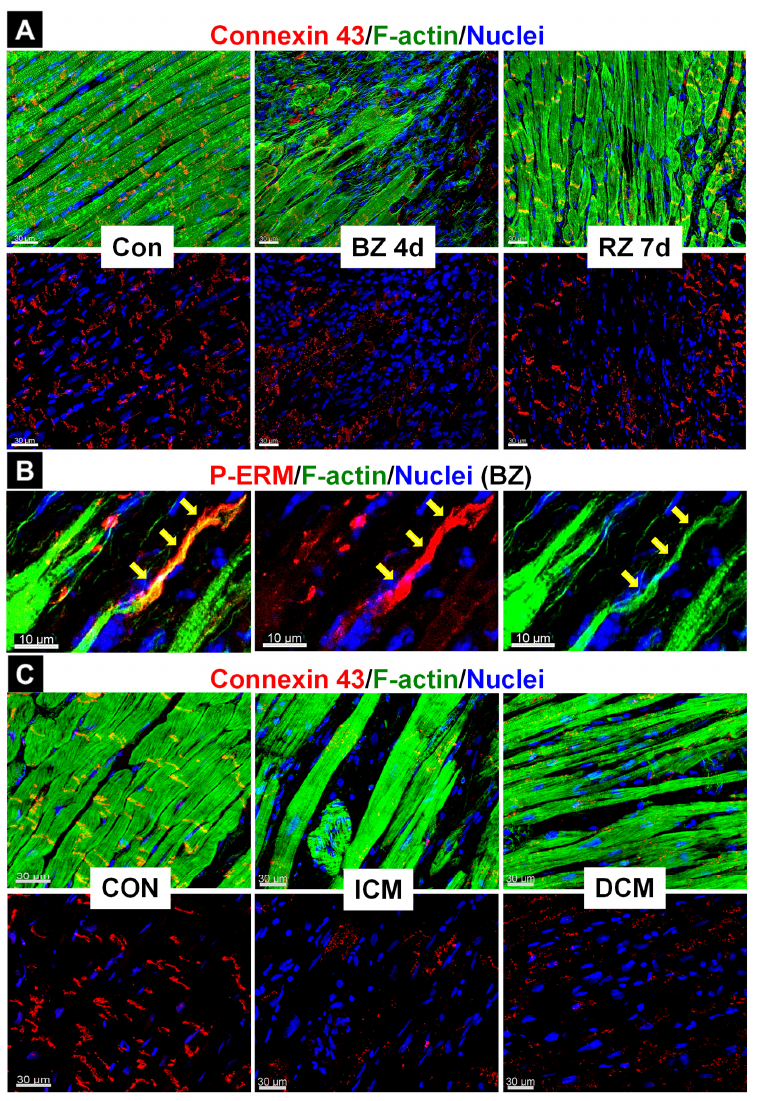
Figure 3. The architecture of intercalated discs is changed in the diseased myocardium. ( A ) Connexin 43, which marks intercalated discs in the normal heart, is downregulated/rearranged in cardiomyocytes of the border and remote zone in the infarcted mouse myocardium. ( B ) P-ERM (a marker of activated Ezrin/Radixin/Moesin proteins) characterizes the formation of cardiomyocyte extensions (yellow arrows) in the infarcted mouse myocardium. ( C ) Similarly, connexin 43 is downregulated in patients with ischemic (ICM) and dilated (DCM) cardiomyopathy, indicating remodeling of intercalated discs. CON represents human control tissue.